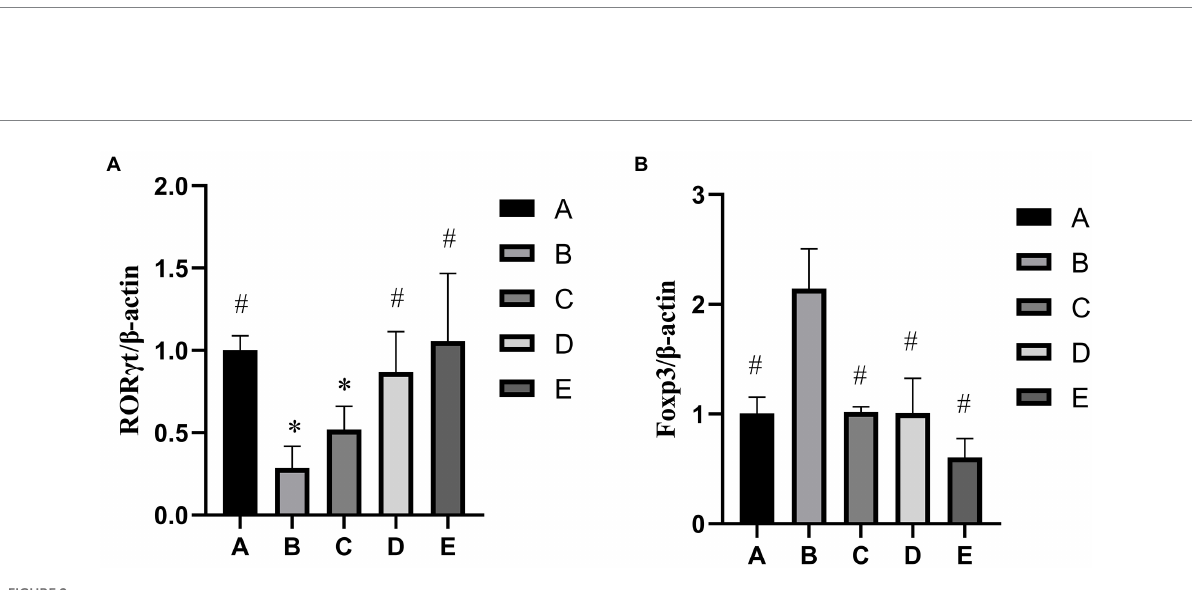
FIGURE 2 Effects of CSPCM on relative genes expression. (A) Effects of CSPCM on ROR γ t/ β -actin gene expression in mice. (B) Effects of CSPCM on Foxp3/ β - actin gene expression in